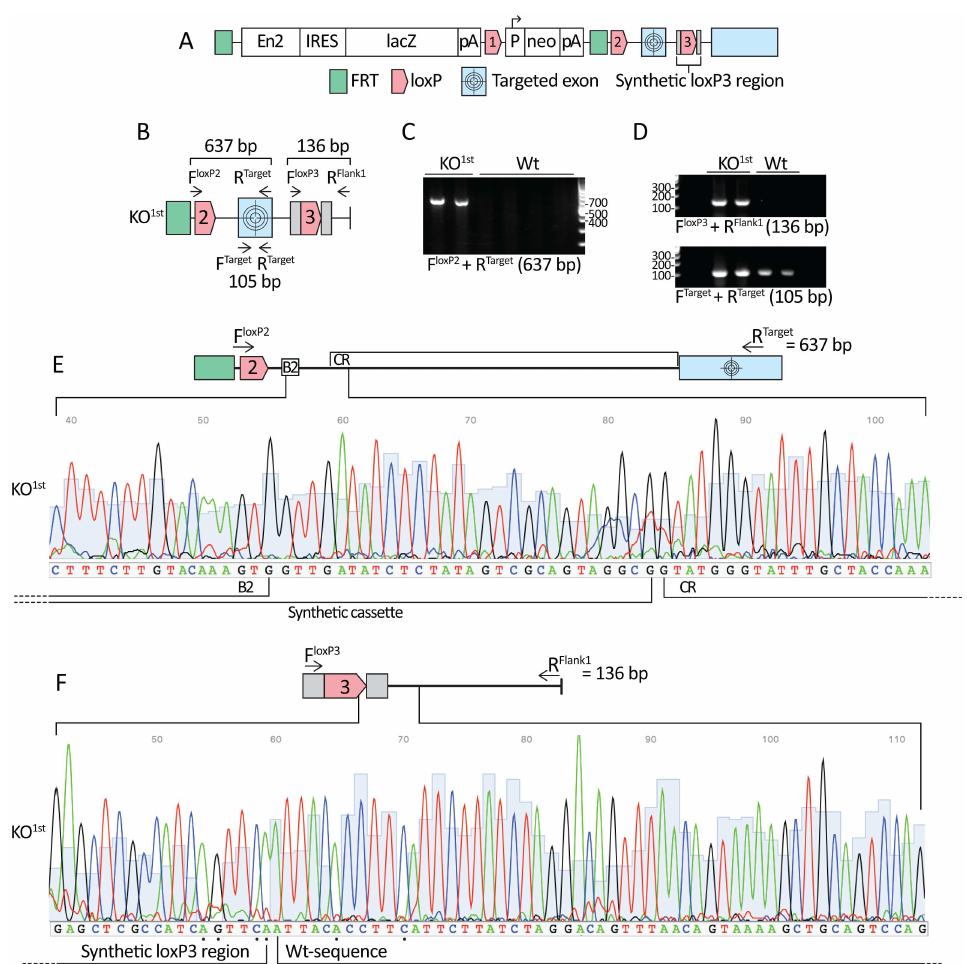
Fig 1. Genotyping Exoc3l2 tm1a(KOMP)Wtsi KO 1st chimeraswith construct-specific primers. A. The Exoc3l2 tm1a(KOMP)Wtsi KO 1st construct with conditional potential.The targeted exon is flankedby a loxP (loxP2) and a synthetic loxP3 site. The final blue box represents the terminal exon of the Exoc3l2 gene encodedby the construct. B. Combiningprimers designedto target loxP2 (F loxP2 ) and the target exon (R Target ) was predictedto amplify a PCR product of 637 bp. The primer F loxP3 targeted the synthetic loxP3 region and in combination with the R Flank1 primer it was predictedto producea 136 bp product from KO 1st templates. The F Target and R Target primers amplify a sequenceof 105 bp from the targeted exon, common to all samples. C. PCR using the F loxP2 and R Target primers confirmed the KO 1st genotypein DNA samples extracted from KO 1st chimera biopsiesand amplifiedno product in samples extracted from Wt biopsies. D. PCR using the F loxP3 and R Flank1 primers with KO 1st and Wt biopsies also produced a PCR product close to the predictedsize in KO 1st chimera samples and no product in Wt samples. PCR with F Target and R Target primers amplifieda product close to the predictedsize in all samples. E. Sanger sequencingof the PCR products from C. confirmed the KO 1st specific identity of the amplifiedproduct. F. Sanger sequencingof the 136 bp PCR product amplifiedusing the F loxP3 and R Flank1 primers confirmed the correct position of the junction betweenthe synthetic loxP3 sequenceand the Wt sequence.Black dots were placed under bases of low quality, but the specific base peaks at these positions were identical to those predictedfor this sequence. PCR was performed with an annealingtemperature of 56˚C and products were separated on 1% agarosegels containingGelRed stain. Each of the two KO 1st lanes in C and D represent PCR products derived from two distinct KO 1st chimeric mice. Abbreviations : B2: B2 Gateway (Gateway cloningstrategy element) | CR: Critical region of Exoc3l2 (identifiedby KOMP) | En2/SA: Engrailed-2/ Splice acceptor | IRES: Internal ribosome entry site | lacZ: Lactose operonZ ( β -galactosidase gene) | pA: SV40 polyadenylation site | P: Humanbeta actin promoter | neo: Neomycin resistance gene | KO 1st : Knockout first chimera.